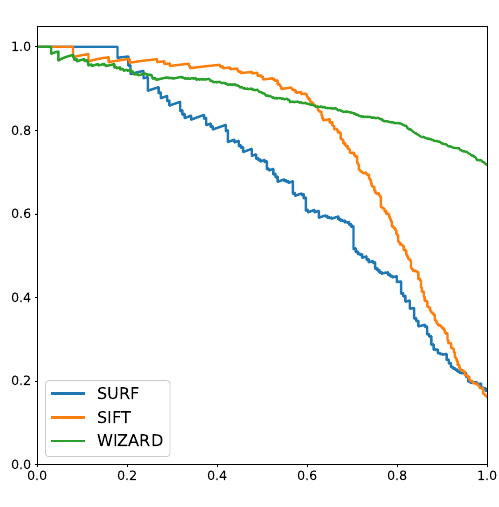
Figure 7. Precision-Recall curves for the SIFT, the SURF, and the WIZARD descriptors